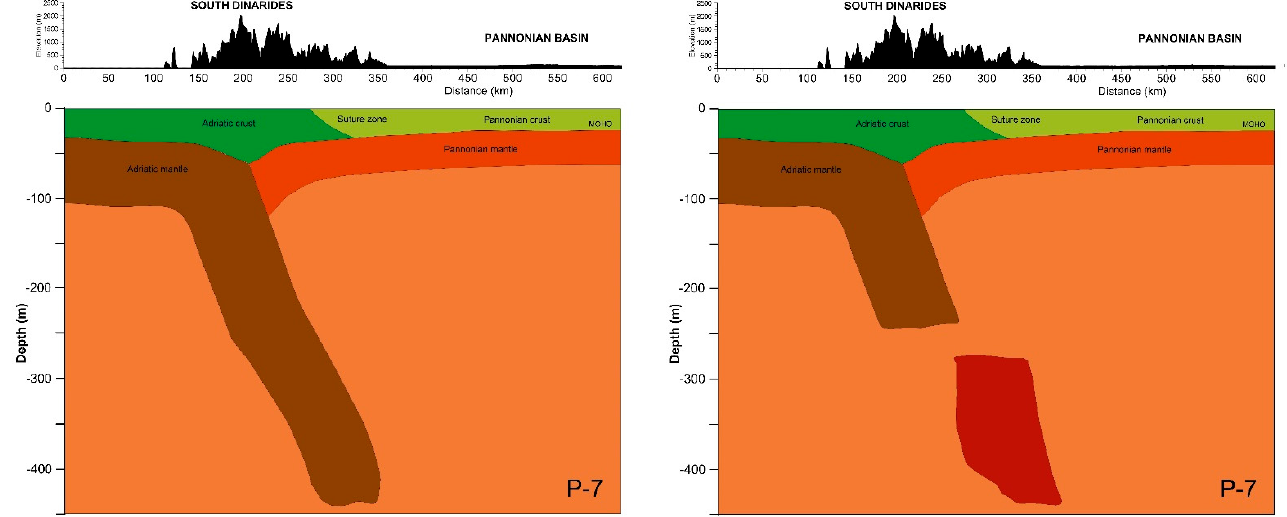
Figure 9. Two possible structural models of the lithosphere in the Southern Dinarides can be devised using forward seismic modelling. The first model (on the left) assumes a steeply dipping continuous Adriatic lithospheric slab [8]. The second model (on the right) presumes that the Adriatic slab consists of two separate blocks, with the deeper block resulting from delamination of the Adriatic lithosphere in a previous subduction. The position of profile P-7 is shown in Figures 1 and 4.